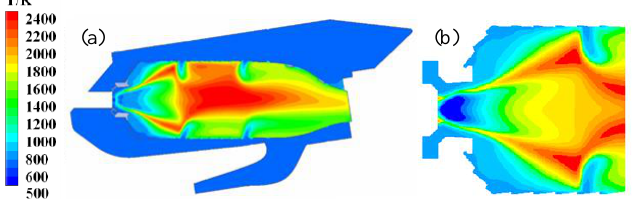
Figure 4. Numerical results of ( a ) Li [54] and ( b ) the present study.